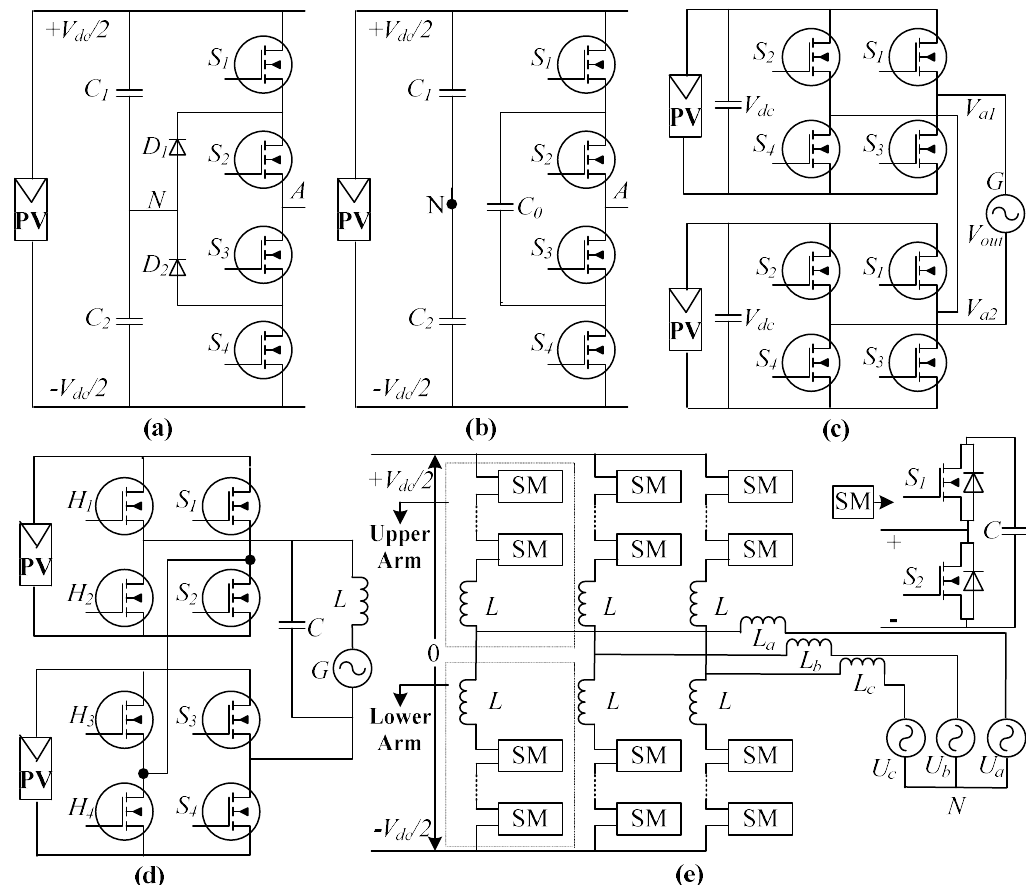
Figure 6. Power circuitry of grid-connected multi-level inverter (GCMLIs): ( a ) 3-level neutral point clamped (NPC) [53]; ( b ) 3-level flying capacitor (FC) [54]; ( c ) 3-level cascaded H-Bridge (CHB) [59]; ( d ) 9-level CHB with FC [11]; and ( e ) 3-Ф modular topology [65].